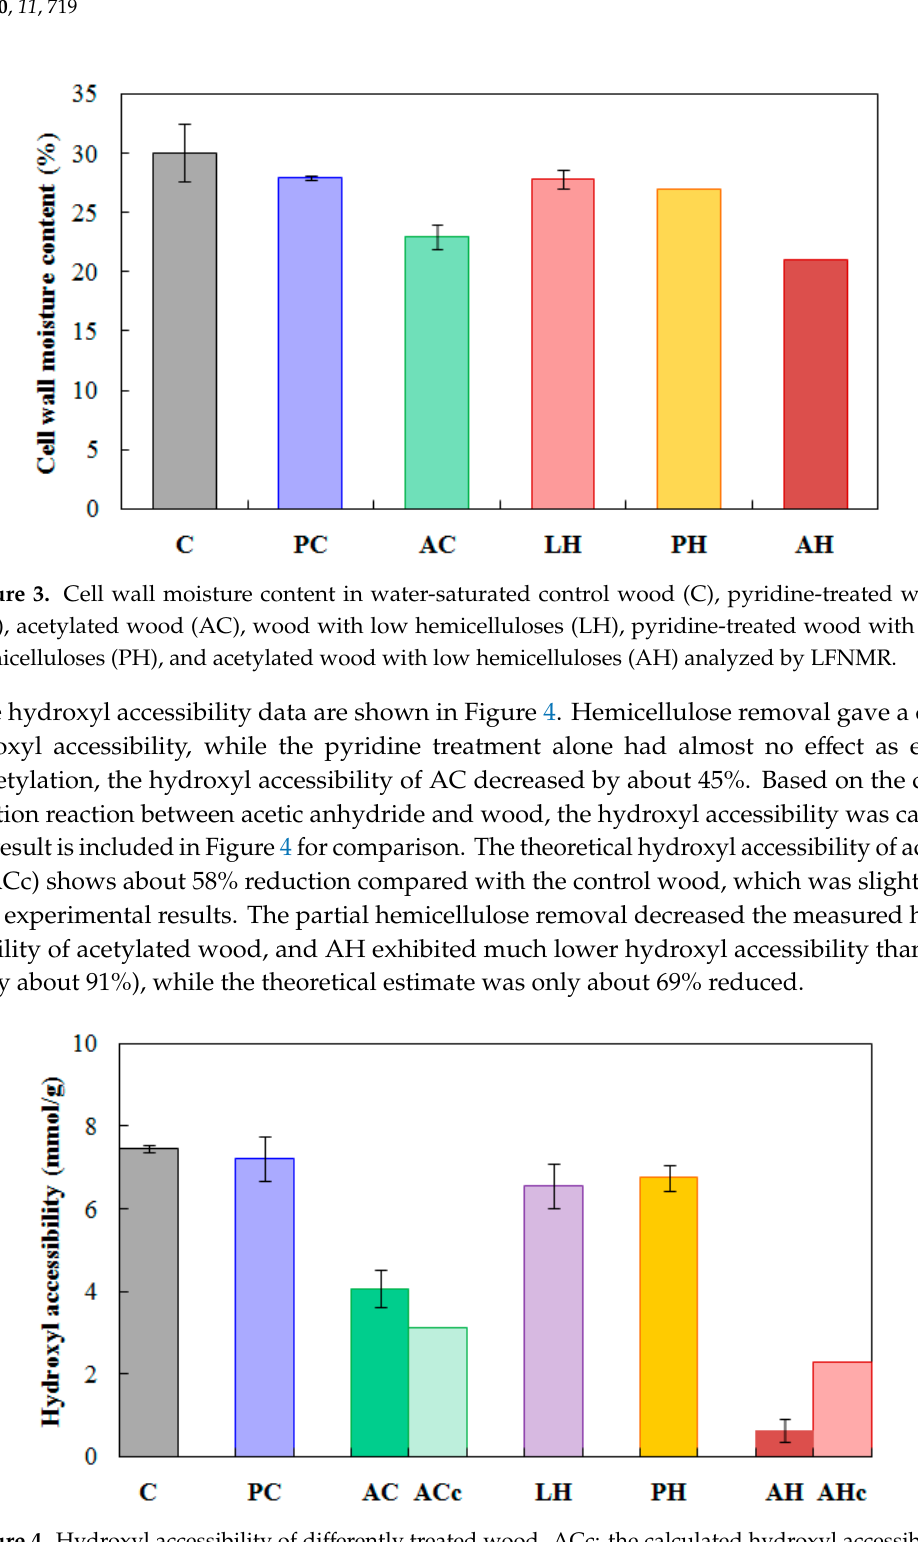
6 of 13 Figure 2. Continuous T 2 (spin–spin) distributions for control wood (C), wood with low hemicelluloses (LH), pyridine-treated wood (PC), acetylated wood (AC), and acetylated wood with low hemicelluloses (AH). Gray filled areas represent mean values including standard deviation. Based on the peak integral area of the total area analyzed by LFNMR, the cell wall moisture content of the differently treated wood can be calculated and compared, but the absolute value of the cell wall moisture content is most probably under-estimated [9]. As shown in Figure 3, partial hemicellulose removal slightly reduced the cell wall moisture content, but not to a large extent. A